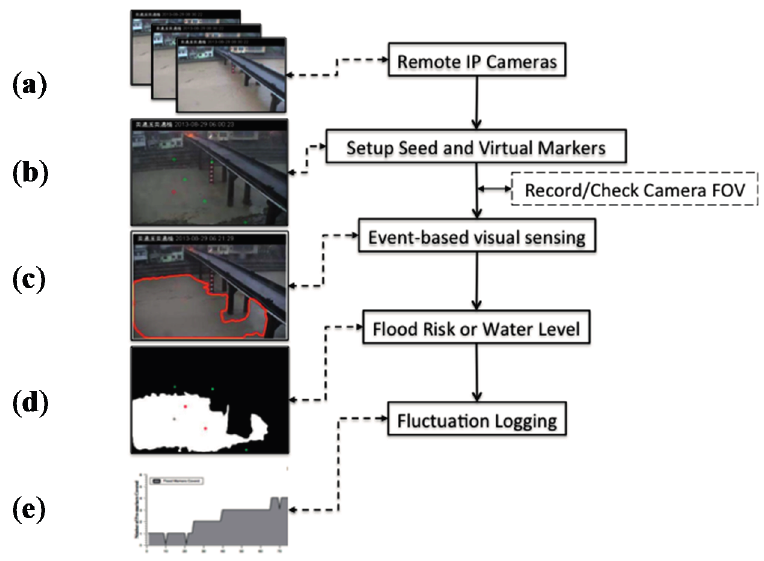
Figure 2. Flowchart of visual sensing process for floods. Before image analysis, ( a ) check whether the camera’s field of view (FOV) is correct; ( b ) set up a virtual seed and